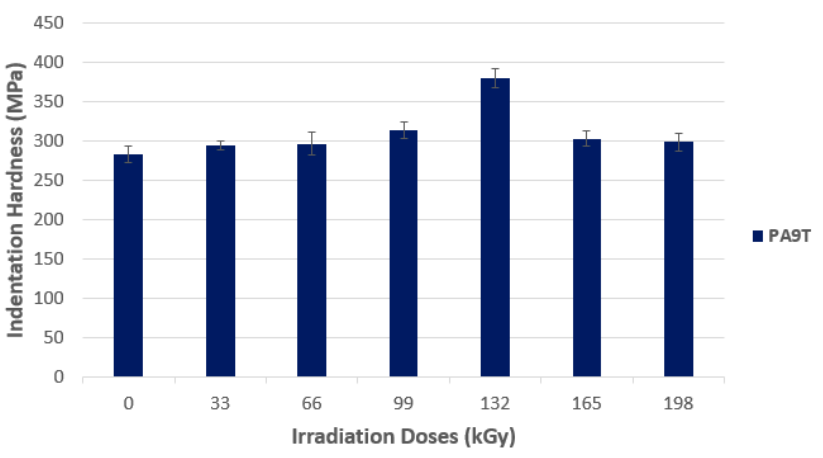
Figure 19. Indentation hardness ( H IT )—High-performance polymers.